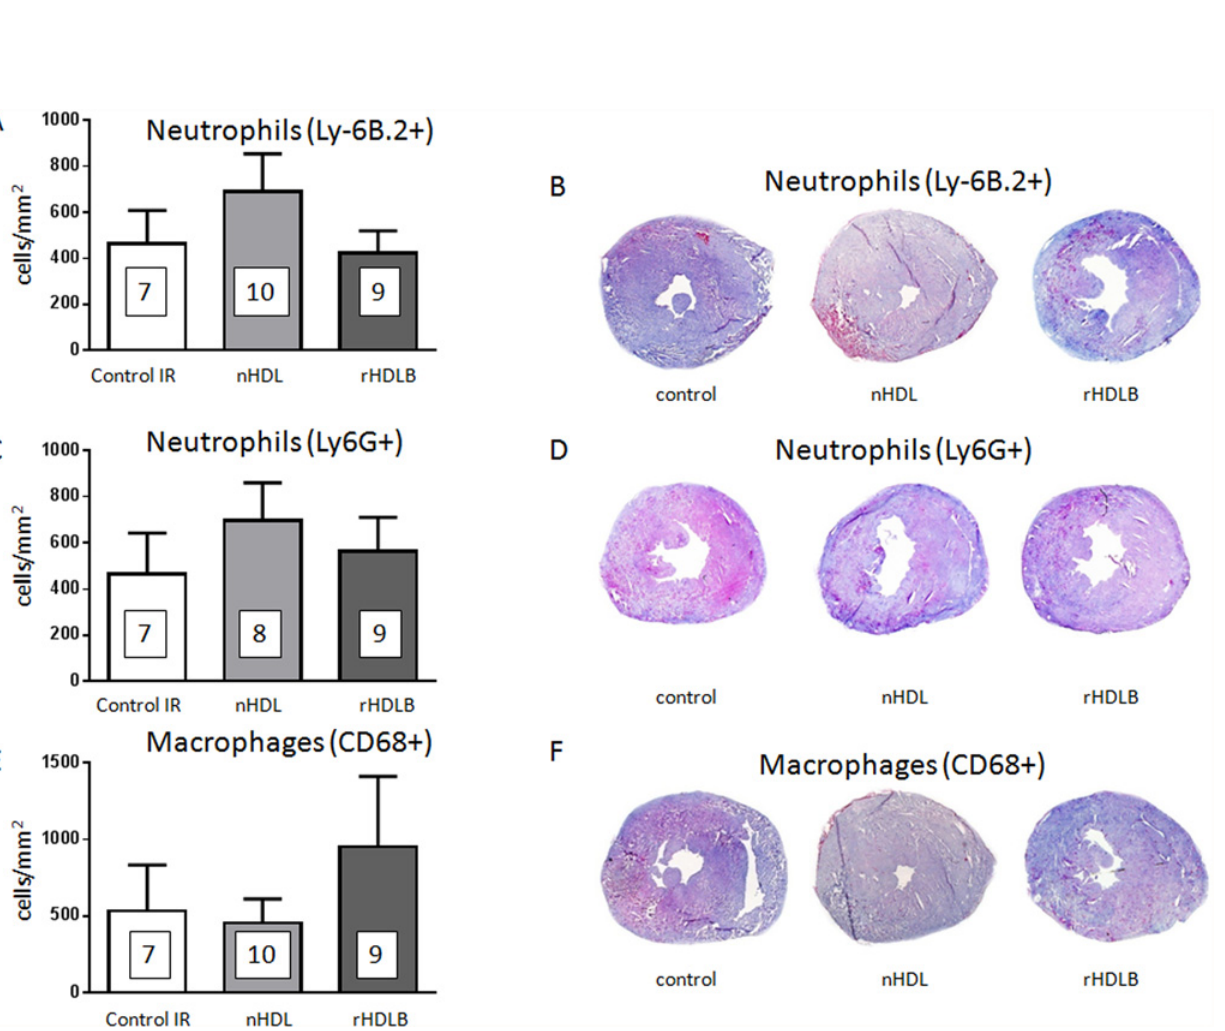
Fig 5. Post-ischemic treatment with HDL does not decrease leukocyte infiltration. Mice were submitted to LAD occlusion for 45min and hearts were reperfused for 24h. Mice were injected or not (control mice IR) with native HDL (nHDL), rHDLB (apoAI + POPC + S1P) one minute before reperfusion. A. Quantification of infiltrated neutrophils (Ly-6B.2 + cells) per area in frozen sections of infarcted hearts at 24h of reperfusion. B. Representative images of neutrophil (Ly-6B.2 + cells) infiltration. C. Quantification of infiltrated neutrophils (Ly6G+ cells) per area in frozen sections of infarcted hearts at 24h of reperfusion. D. Representative images of neutrophil (Ly6G+ cell) infiltration. E. Quantification of infiltrated macrophages (CD68 + cells) per area in frozen sections of infarcted hearts at 24h of reperfusion. F. Representative images of macrophage (CD68 + cells) infiltration. Data are expressed as scattered plots (mean ± SEM, n = 7 – 10 per group). Results are expressed as percentages of stained area on total heart surface area. No significance difference between groups was found using unpaired-student